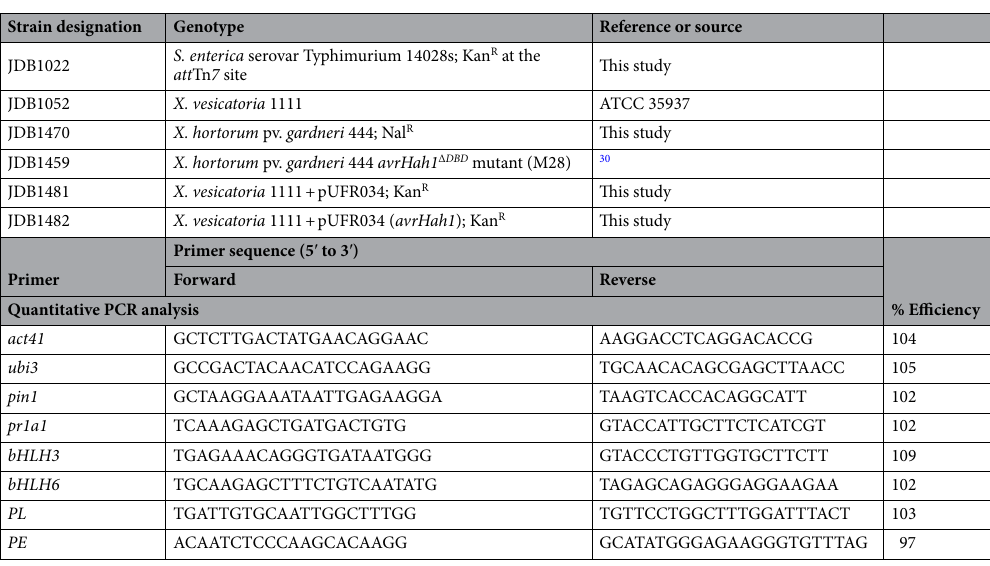
Table 2. List of Strains and